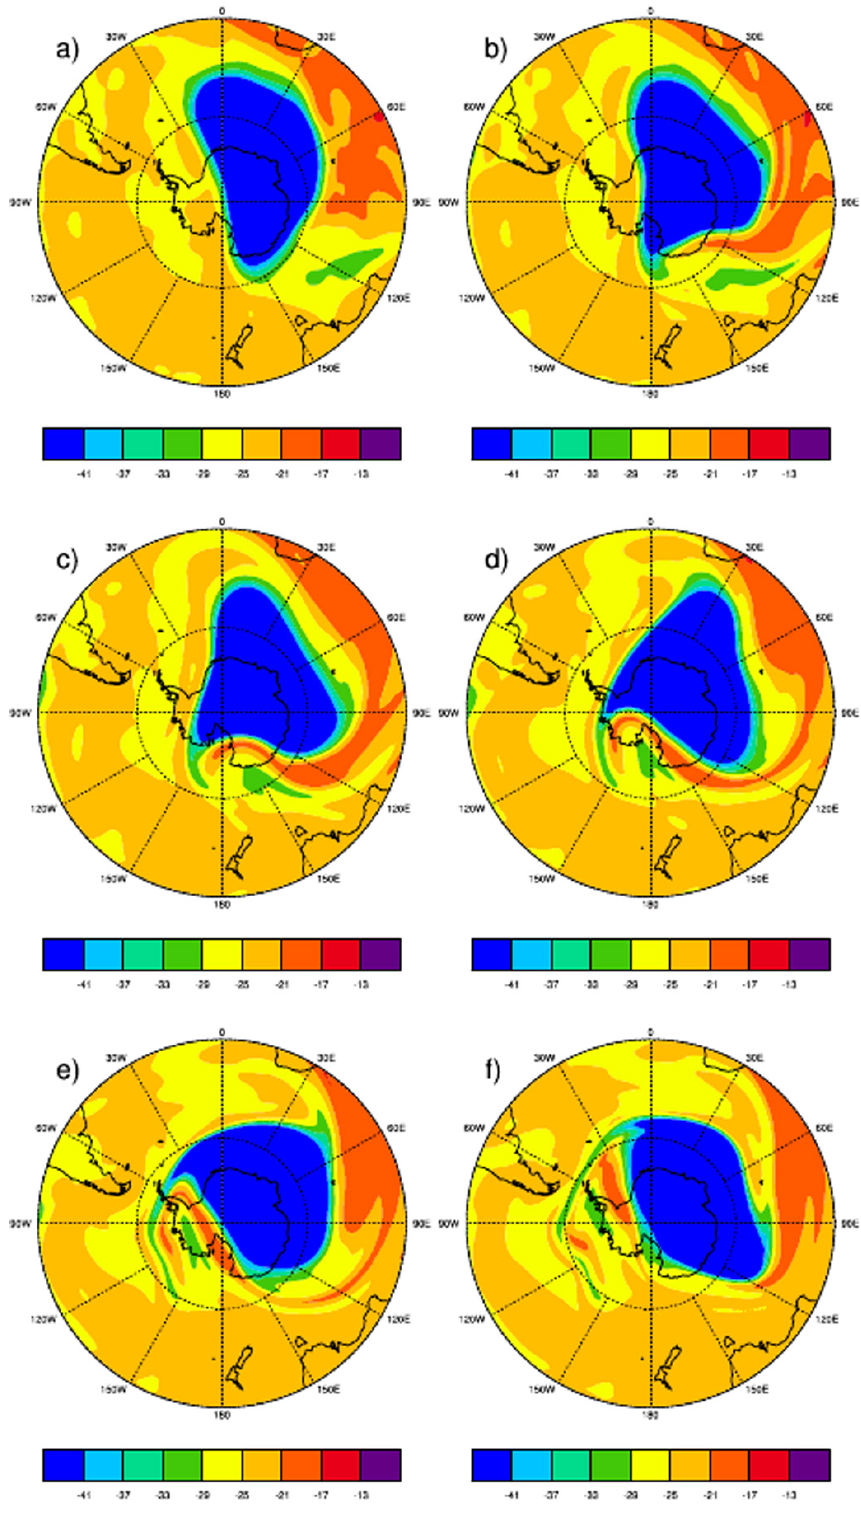
Fig. 7. A sequence for the magnitude of potential vorticity fields obtained from the 3-D isentropic model simulations at 500K level on